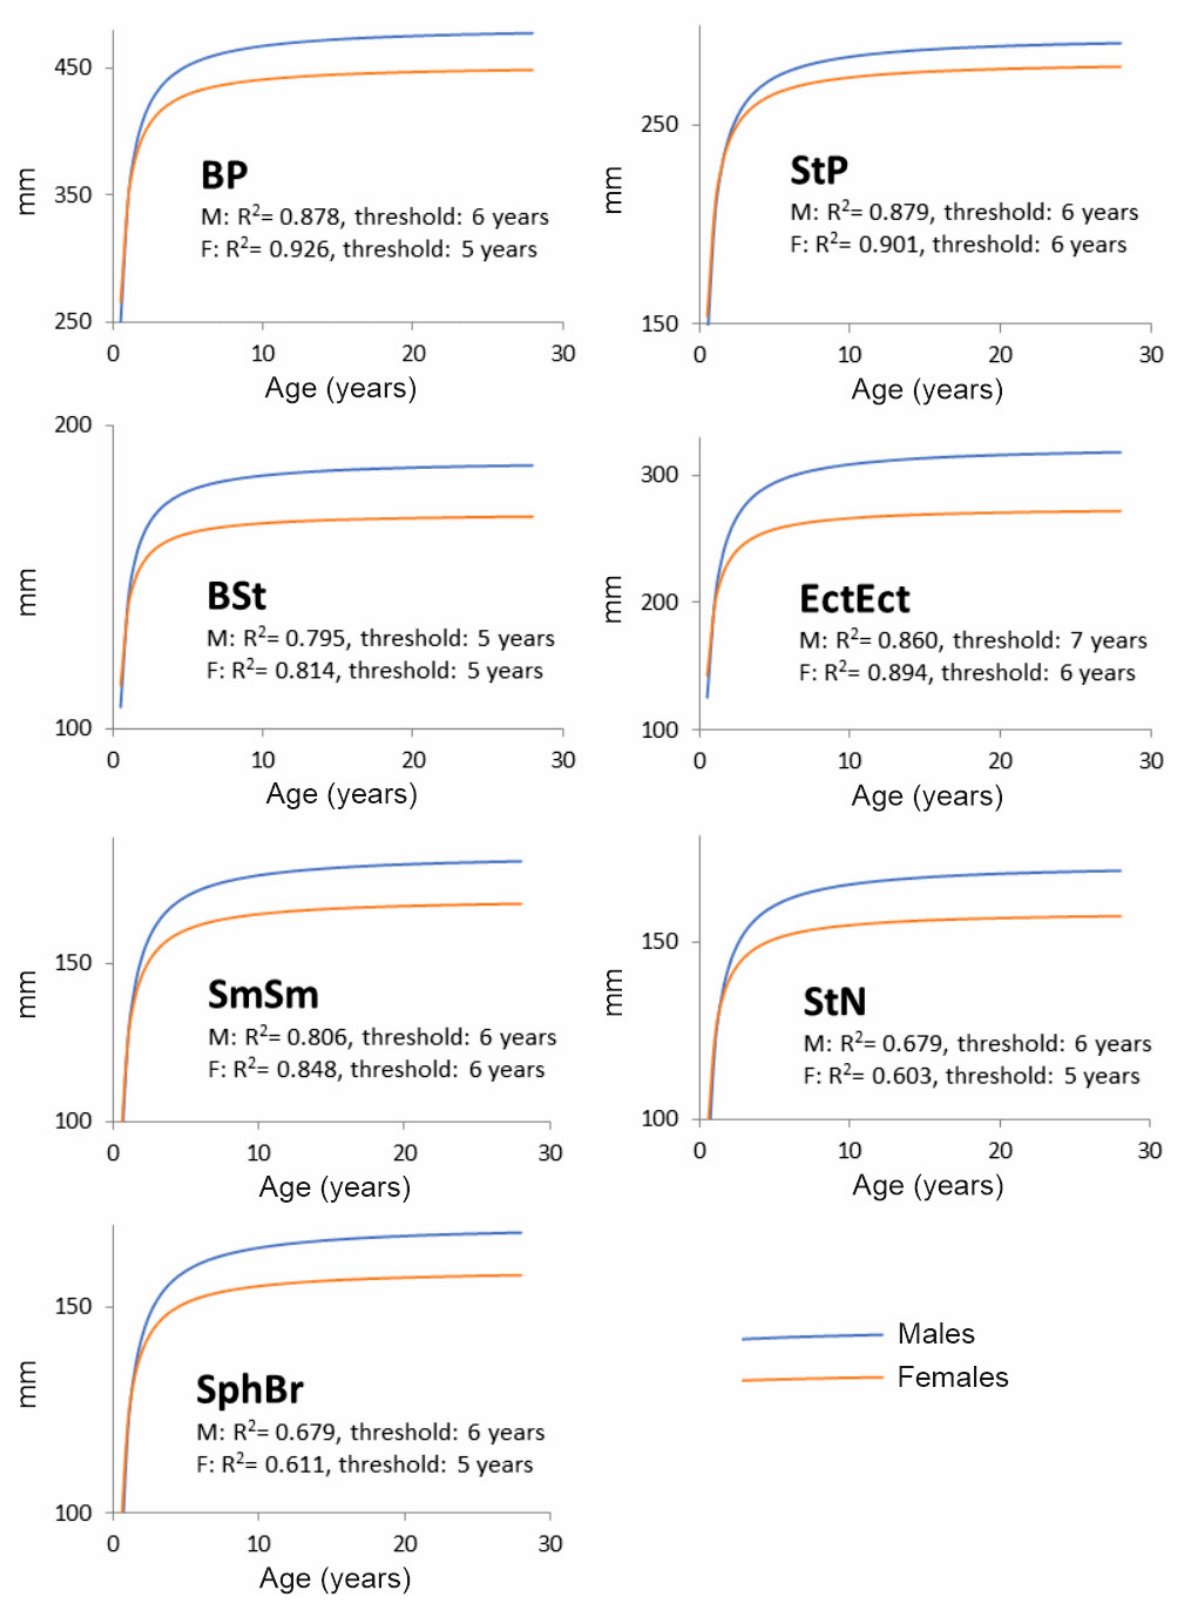
Figure 2. The trend of dimensions changes with the age of male (M) and female (F) European bison and the age threshold for which the dimension value does not increase more than 1% per year of life (for index description see: Methods).